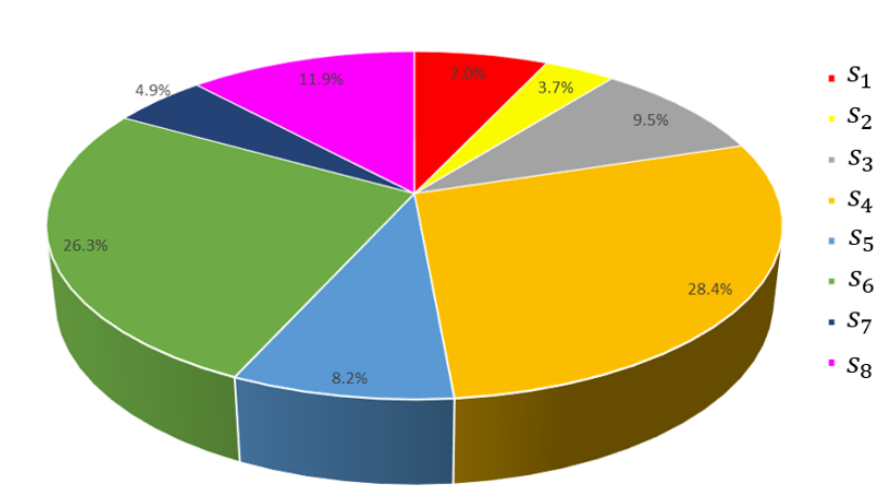
Figure 7. Percentages of eight